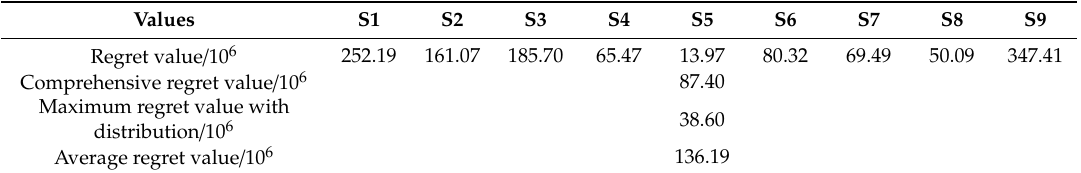
Table 5. Regrets under multiple natural gas price fluctuation scenarios.